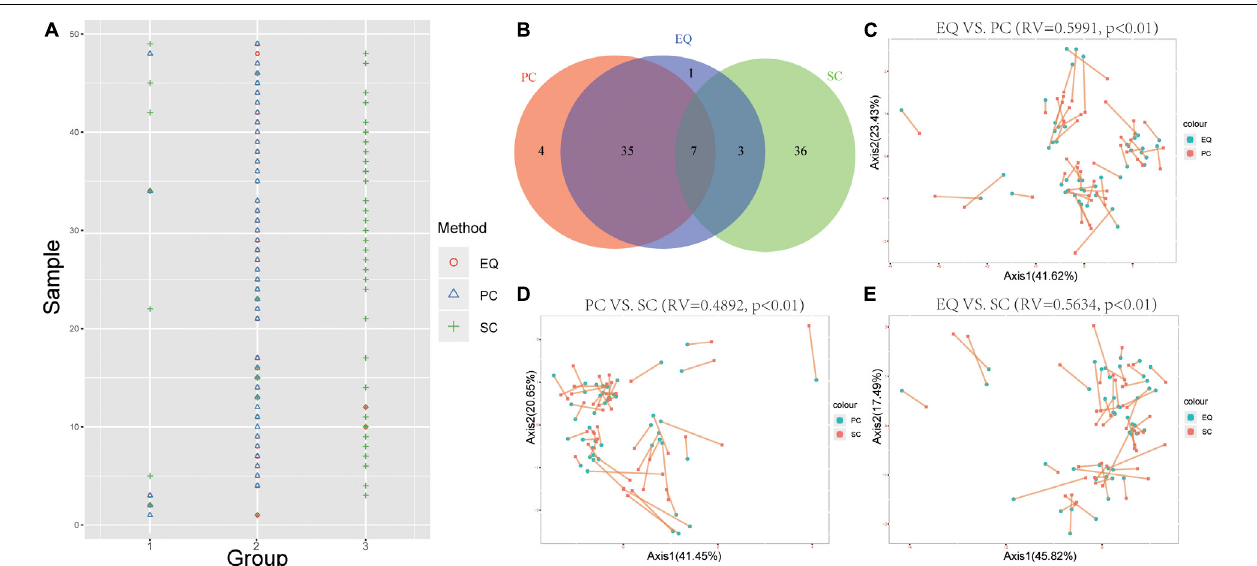
FIGURE 6 | Correlation of EQ, PC, and SC profiles. (A) Grouping information for each sample by PCA. Colors and shapes represent three exosome isolation methods. Y-axis shows the sample number. X-axis shows the grouping information. (B) Venn diagram represents EQ, PC, and SC samples that are grouped into the same clusters. (C) Co-inertia analysis (CIA) of relationships between the EQ and PC miRNA expressional PCA. (D) CIA of relationships between the PC and SC miRNA expressional PCA. (E) CIA of relationships between the EQ and SC miRNA expressional PCA. (C–E) p -value < 0.01 from 99 Monte-Carlo